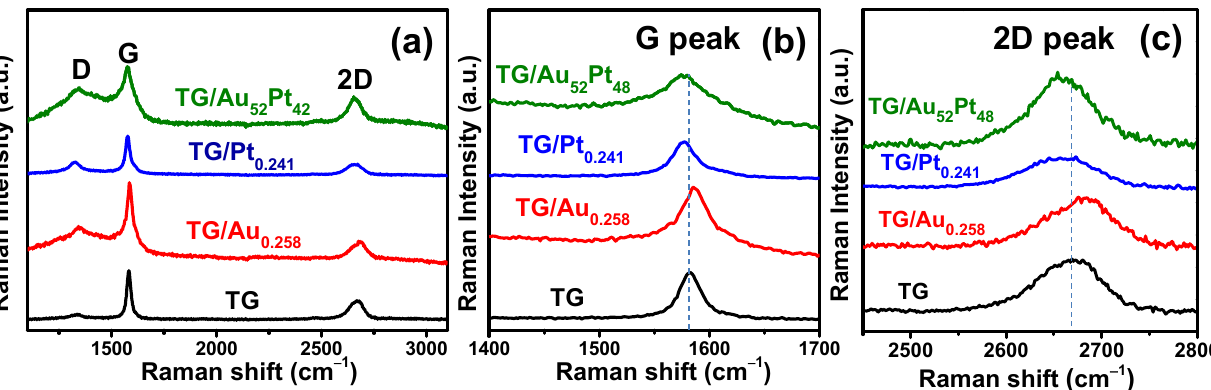
Figure 4. (a) Raman spectra of the TG, TG/Au 0.258 , TG/Pt 0.241 , and TG/Au 52 Pt 48 catalysts; ( b ) the shift of G peak; ( c ) the shift of 2D peak.